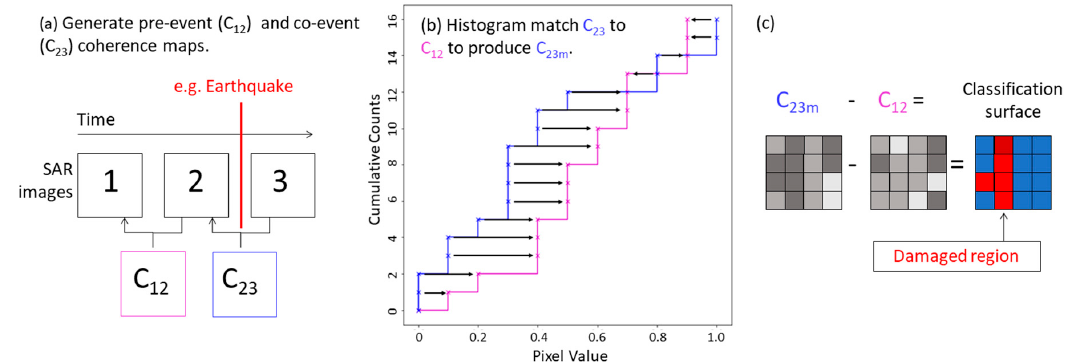
Figure 4. Workflow of the ARIA method [21,39] for identifying ‘damaged’ pixels, for example those which correspond to collapsed buildings or landslides given in 3 steps: ( a ) Generate coherence maps C 12 , C 23 . ( b ) Histogram match C 23 to C 21 . ( c ) Calculate the difference between the two coherence maps. Darker grey pixels in ( c ) have a lower coherence in C 23m and C 12 and negative pixels in the classification surface are identified as ‘damaged’, i.e., those for which C 23m < C 12 .